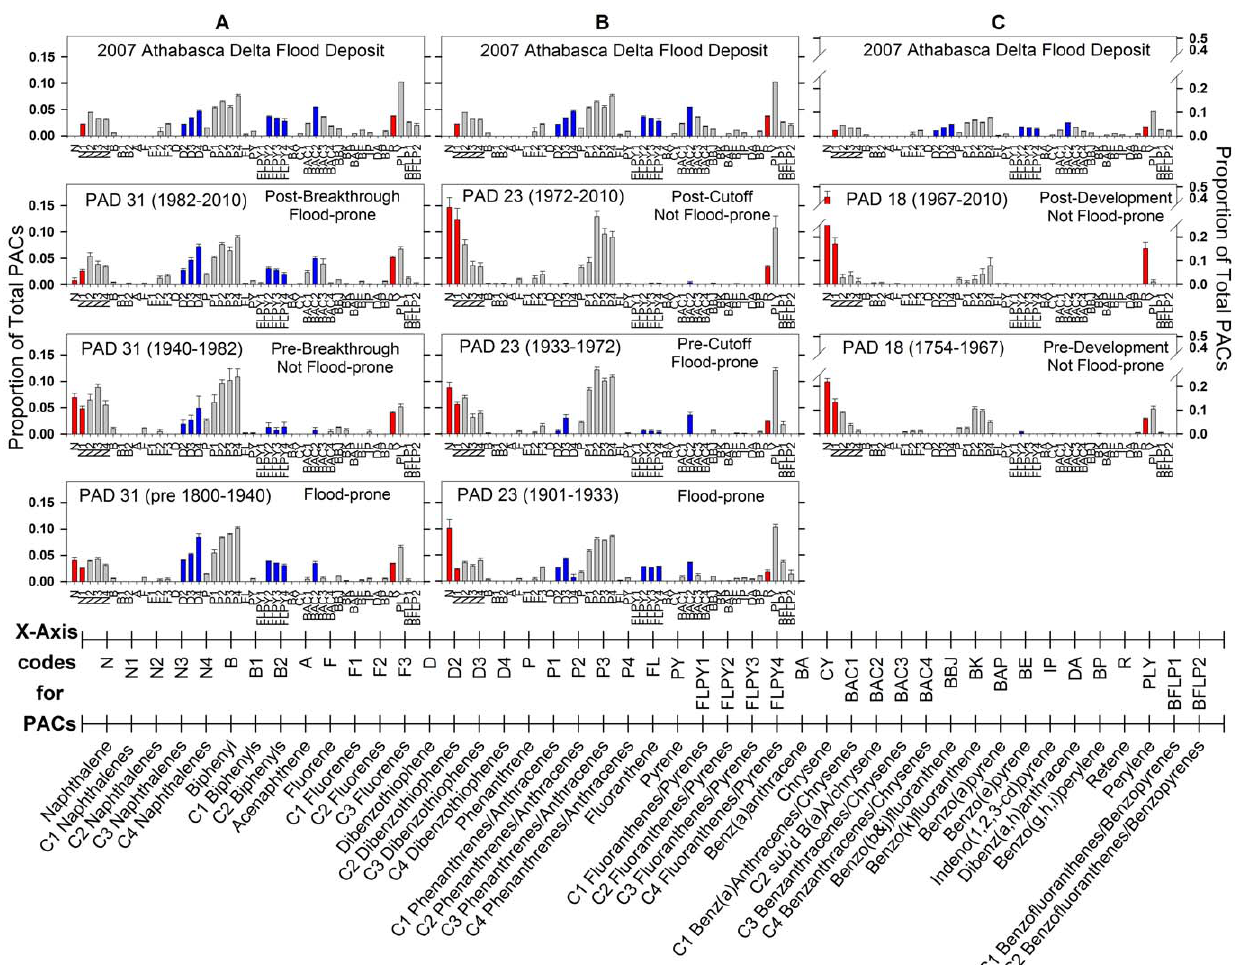
Figure 5. Composition of polycyclic aromatic compounds in river flood sediment and lake sediment cores. Bar graphs showing average composition of polycyclic aromatic compounds (PACs), expressed as relative concentration (proportion; error bars 6 1 SEM) in a) the 2007 Athabasca Delta flood deposit and three intervals of differing flood regime at PAD 31, b) the 2007 Athabasca Delta flood deposit and three intervals of differing flood regime at PAD 23, and c) the 2007 Athabasca Delta flood deposit and two intervals that distinguish pre- and post-1967 onset of major commercial oil sands development at not flood-prone PAD 18 (note different scale of vertical axis). Names of the PAC compounds and the corresponding codes are presented along the lower expanded horizontal axis. Blue vertical bars are PACs identified by SIMPER analysis as river- transported bitumen-associated indicator compounds common in sediments deposited during flood-prone intervals (Table 1). Red vertical bars are PACs identified as indicator compounds in sediments deposited during not flood-prone